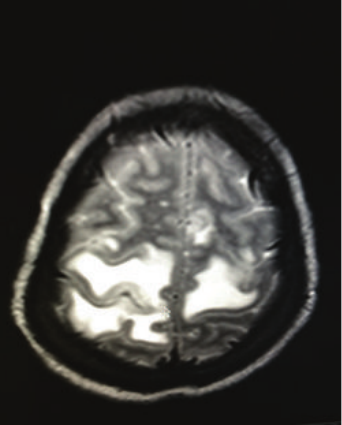
Figure 3: MRI-T2-Axial View: bilateral parietal vasogenic